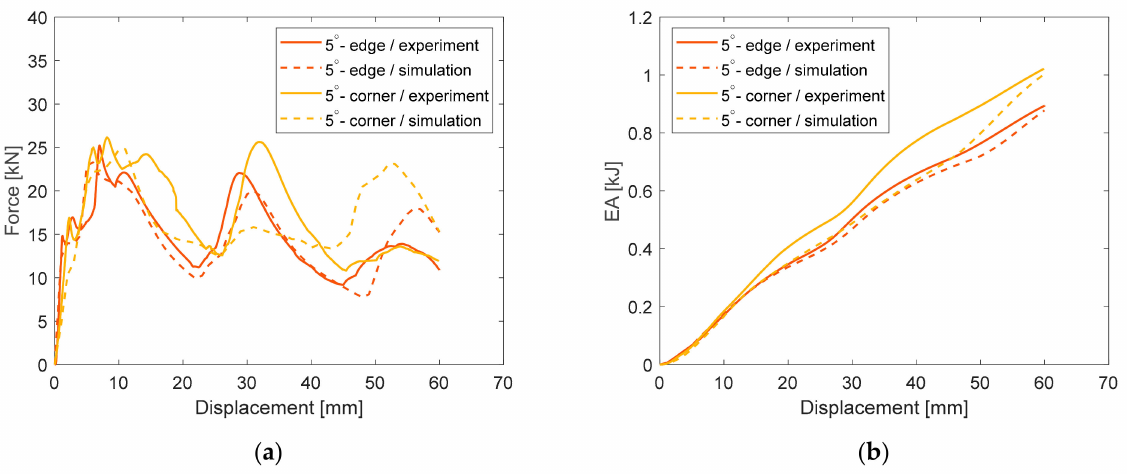
Figure 6. Experimental and numerical results of 5 ◦ crushing angle for cornered and edged oblique impact. ( a ) force-displacement curve; ( b ) EA-displacement curve.